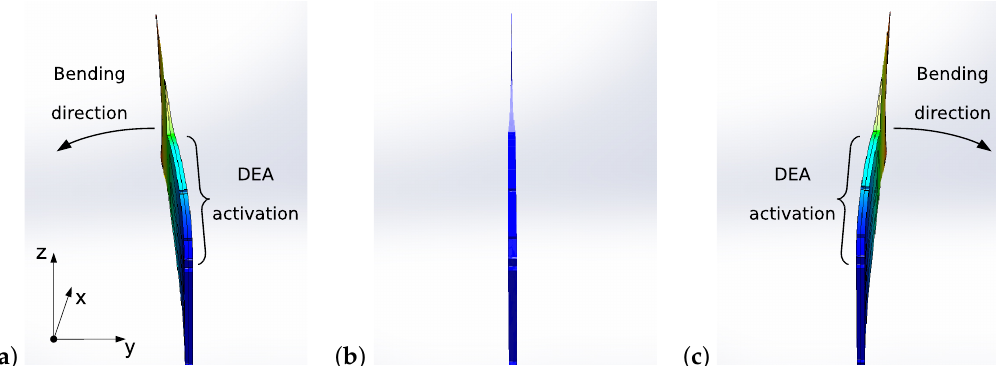
Figure 3. Tri-stable bending principle of the robotic concept: ( a ) bending to the left side by activating the DEA on the right side; ( b ) initial straight configuration without activation of any DEA; ( c ) bending to the right side by activating the DEA on the left